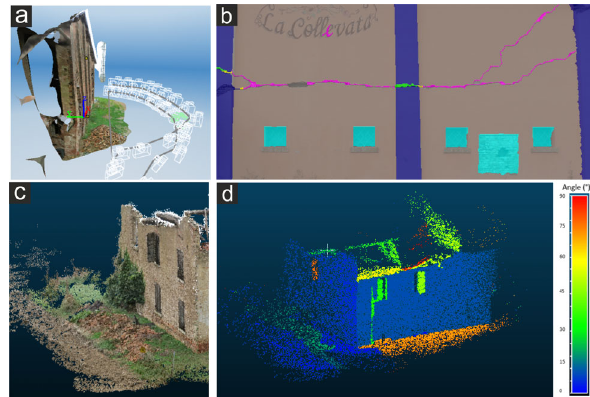
Figure 1. Damages identified from UAV-derived point clouds and from OBIA processing. (a) inclination in walls, (b) openings (turquois), cracks (magenta) and damage crossing beams, (c) and (d) detailed point cloud and segment orientation angles (adapted from Fernandez Galarreta et al. 2015) The work of Fernandez Galarreta et al. demonstrated the significance of geometric information, in particular of